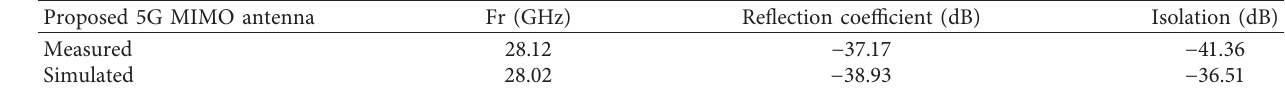
Table 3: Simulated and measured S 11 and S 12 of the 5G MIMO antenna.